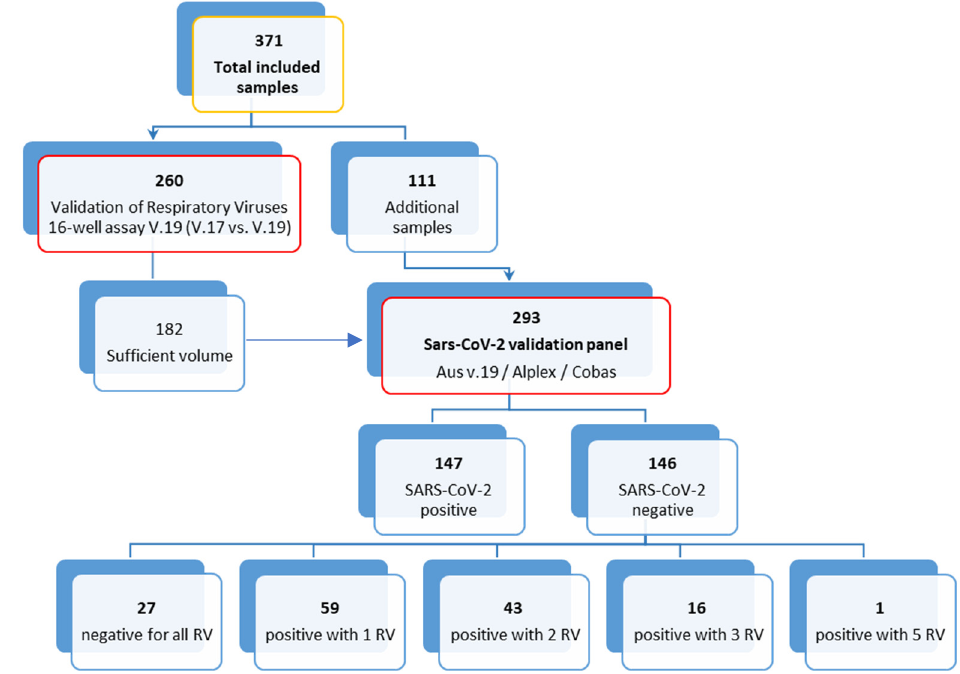
Figure 1. Flow chart of the specimens included in the study. RV = respiratory viruses.